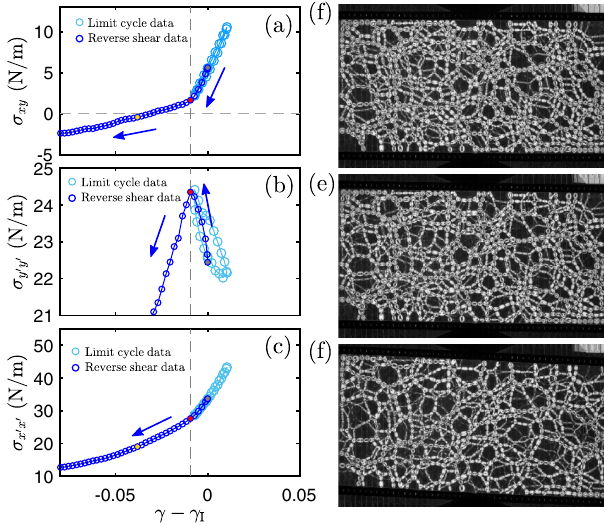
FIG. 5. (a) – (c) The blue circles are data under the reverse shear starting from an ultrastable state formed by applying cyclic shear with strain amplitude δγ ¼ 0 . 95% on an original SJ state formed by δγ ¼ 0 . 189 . The light blue circles show data in the limit cycle. The arrows mark the direction of the reverse shearing. Data in (a) – (c) are the shear stress σ and the two xy eigenvalues of the stress tensor σ and σ . Note that there is x 0 x 0 y 0 y 0 ¼ ð σ − σ Þ = 2 . The vertical dashed line marks the yield- σ xy x 0 x 0 y 0 y 0 ing transition. (d) – (f) are snapshots of the system shown in (a) – (c) ¼ 0 (the ultrastable state), − 0 . 0093 (at the yielding at γ − γ I point), and − 0 . 0381 , respectively. The three states in (d) – (f) are marked by the circles filled by gray, red, and yellow in (a) – (c), respectively.